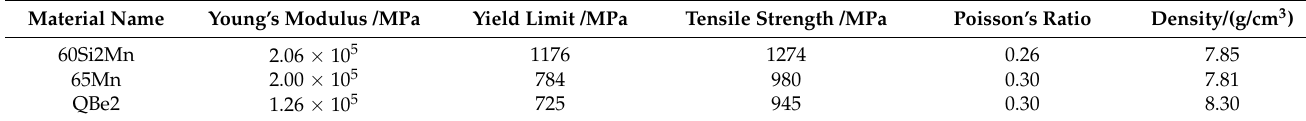
Table 2. Material parameters of flexure hinge.